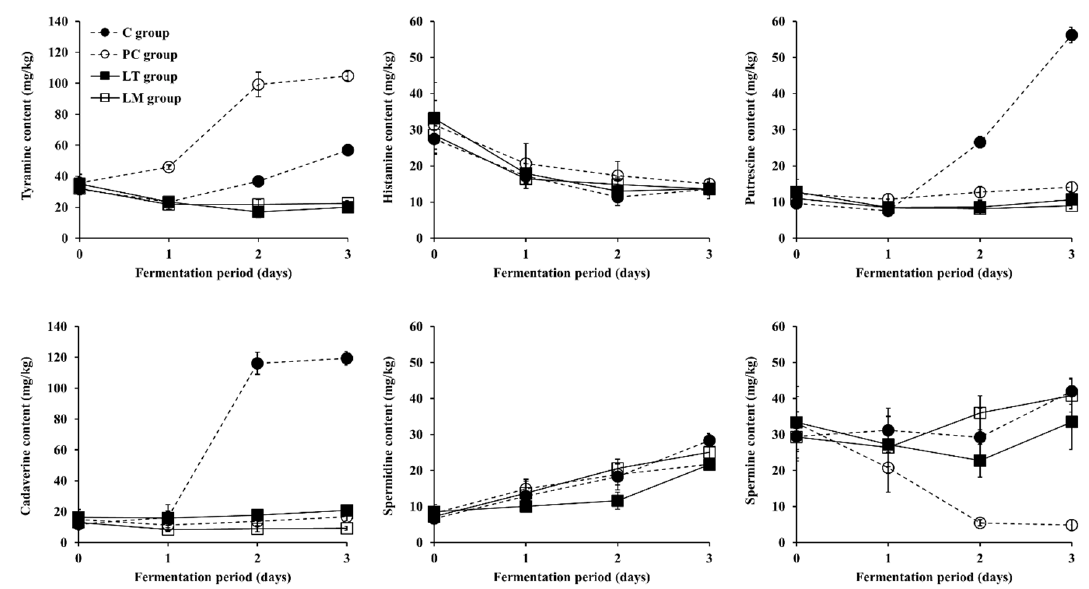
Figure 4. Changes in BA content in Baechu kimchi inoculated with LAB strains leading to moderate tyramine reduction during fermentation. ● : C group without an inoculum (control), ○ : PC group inoculated with tyramine-producing L. brevis isolated from kimchi product (positive control), ■ : LT group inoculated with BA-degrading L. pentosus PK05, □ : LM group inoculated with BA-degrading Leu. mesenteroides YM20.